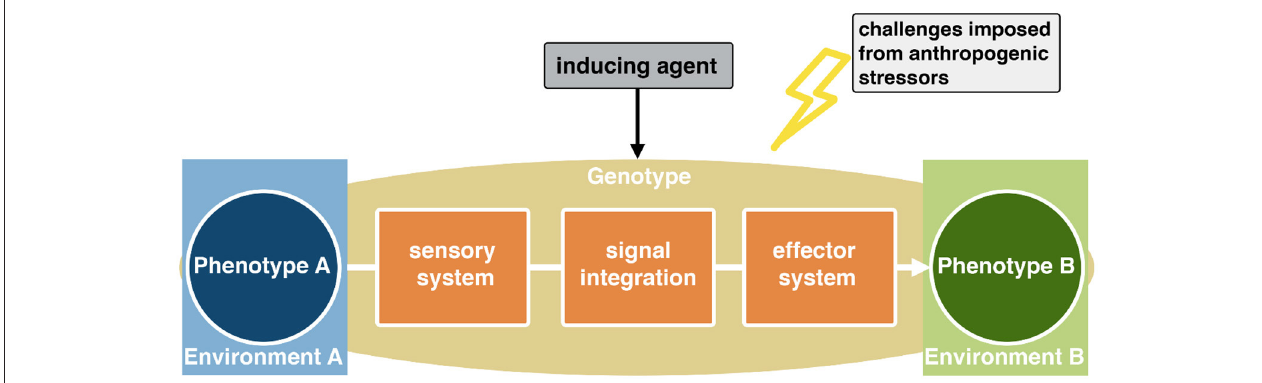
FIGURE 1 | Phenotypic plasticity is realized through a complex cascade initiated by some kind of environmental challenge, which is indicated by a reliable cue. This cue has to be perceived by the organism through a distinct sensory system, and the signal has to be neuronally integrated to change developmental trajectories of effector